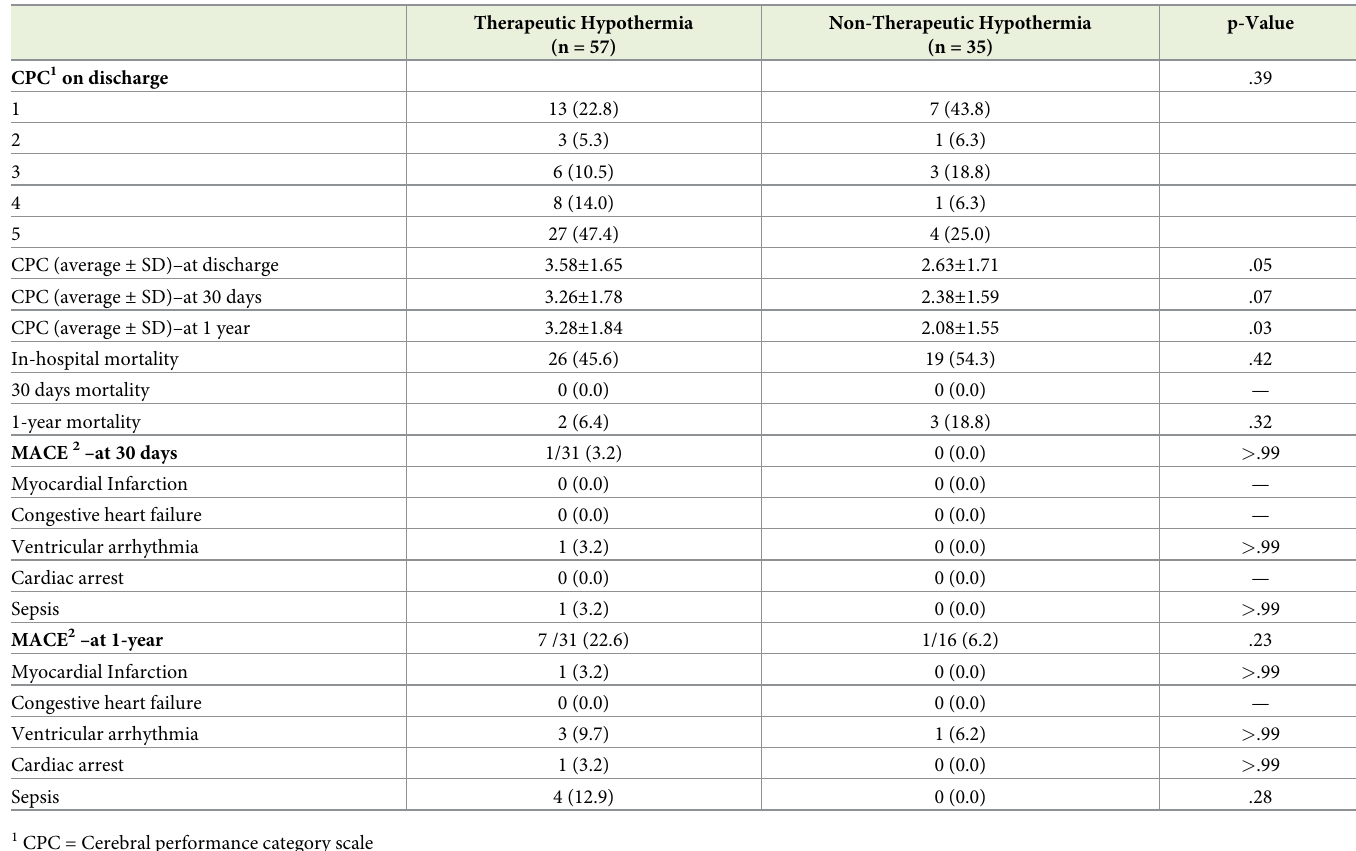
Table 3. Primary and Secondary end points.